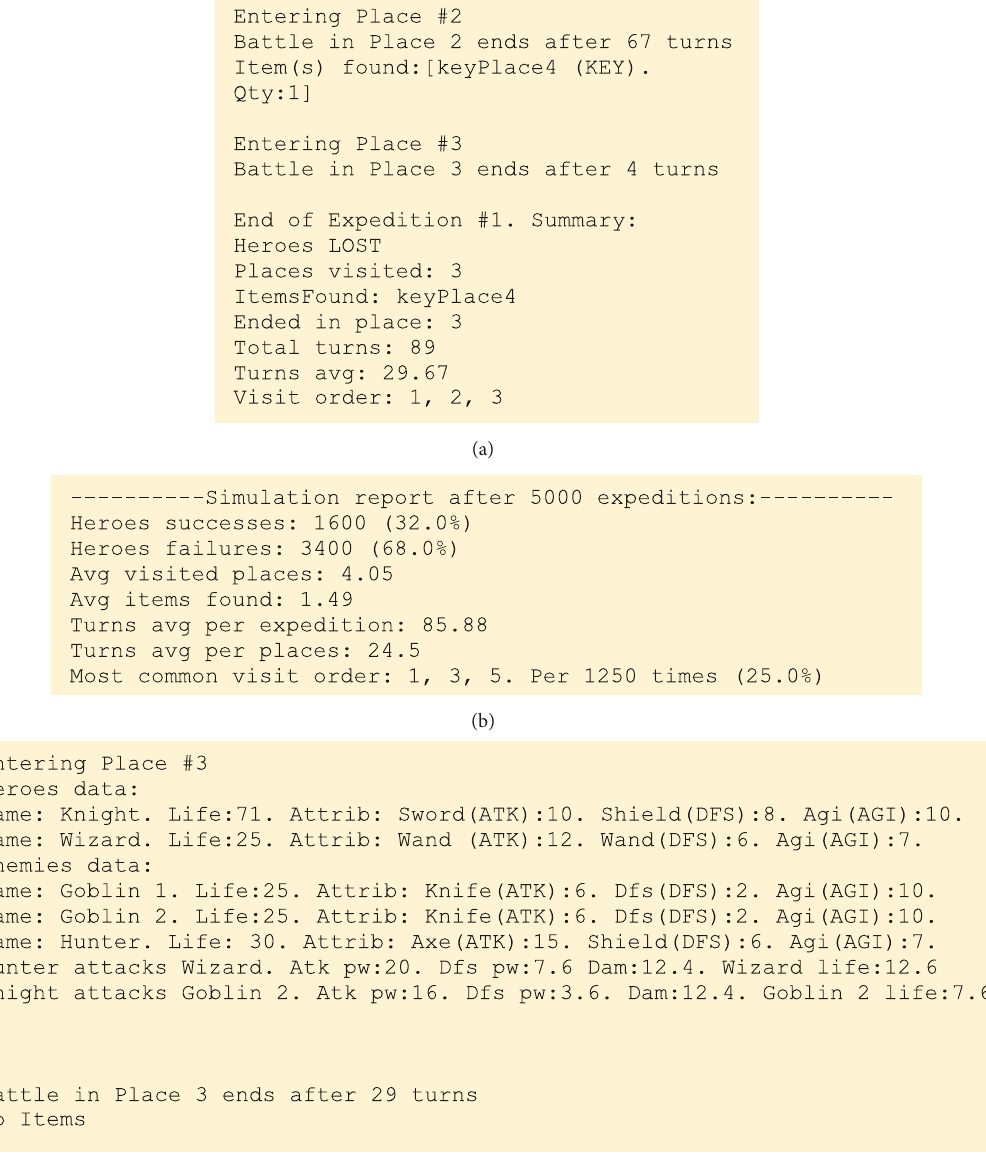
Figure 6: Simulation reports: (a) summary report, (b) consolidated results, and (c) detailed report.